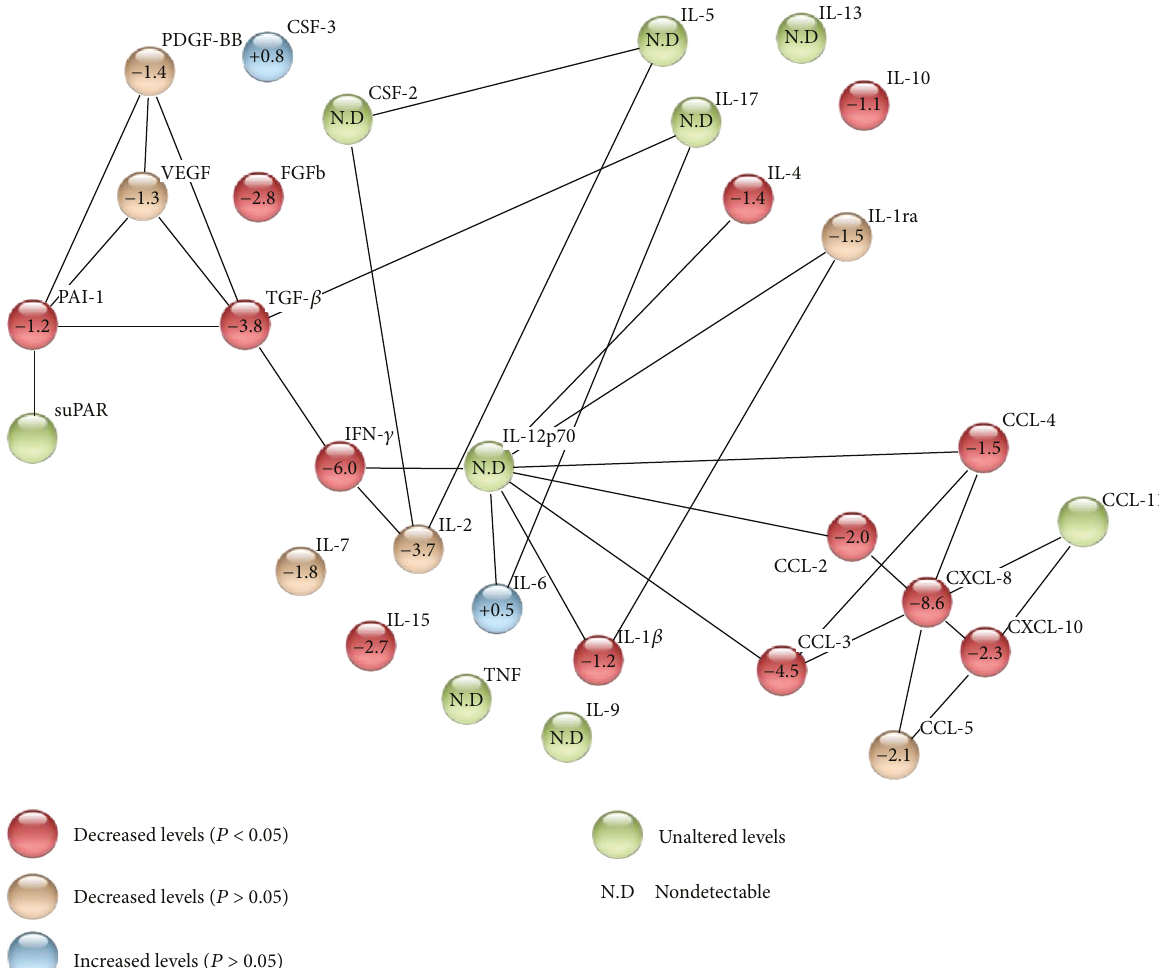
Figure 2: Network of protein-protein interaction, showing up- and downregulation presented by each studied cytokine after DAA therapy. This fi gure was built with software STRING